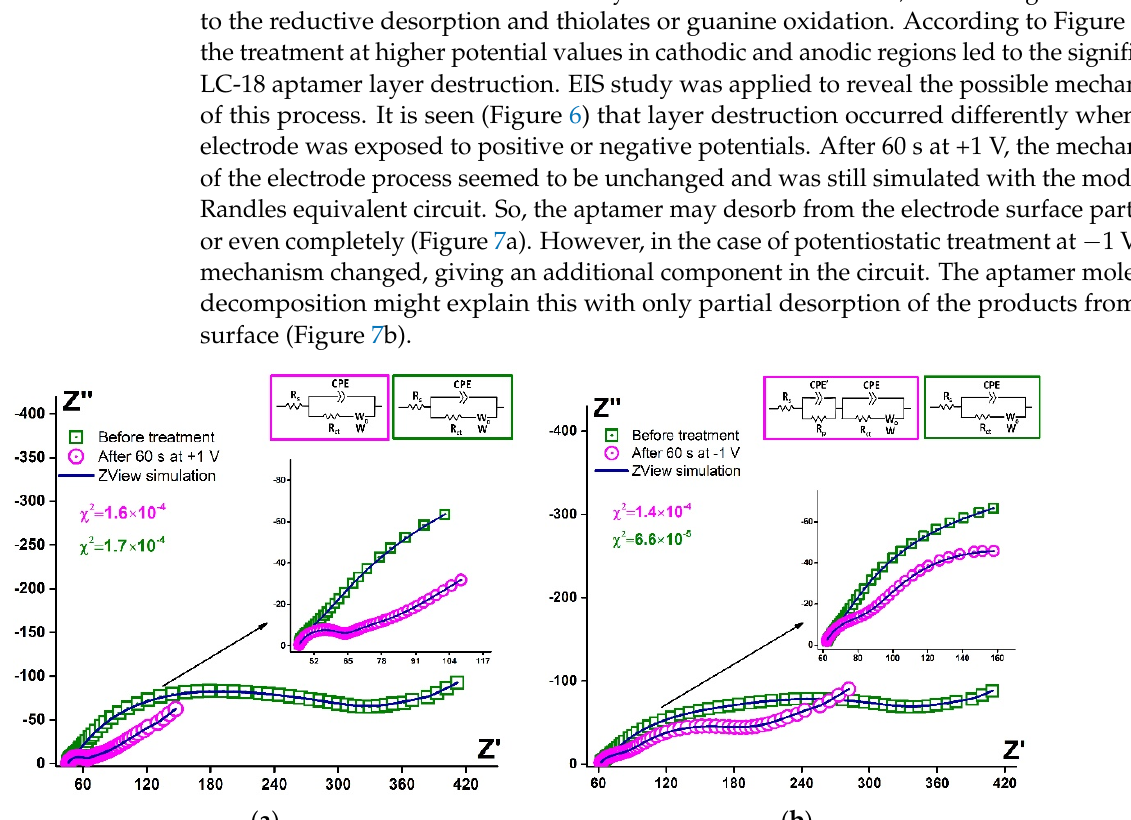
Figure 5. CVs for aptasensor (Au disc/LC-18) before (black dotted curve) and after (colored curves) potentiostatic treat- ment at: ( a ) 0 V; ( b ) +0.4 V; ( c ) –1 V; ( d ) +1 V. Solution: 0.025 M K 3/4 [Fe(CN) 6 ] in PBS (7.4).